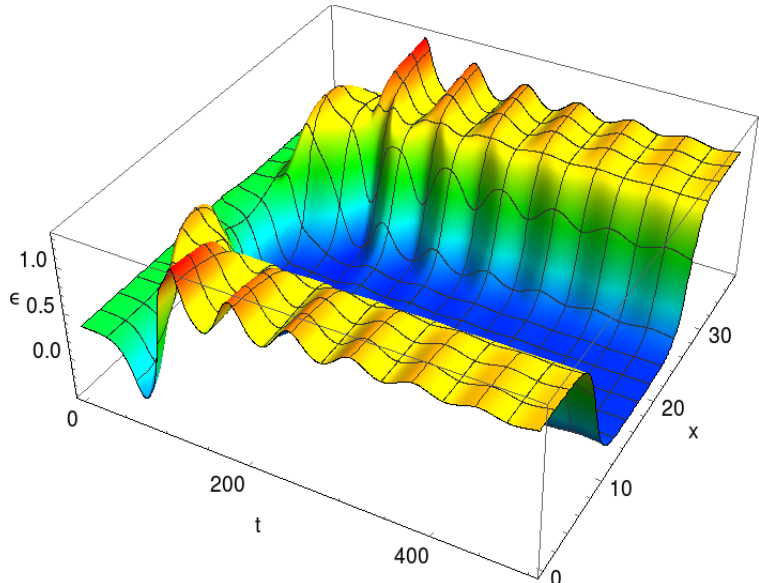
Figure 7 . Space and time dependence of energy density of for (cid:30) H = 2 : 0 with Gaussian perturbation from ref.